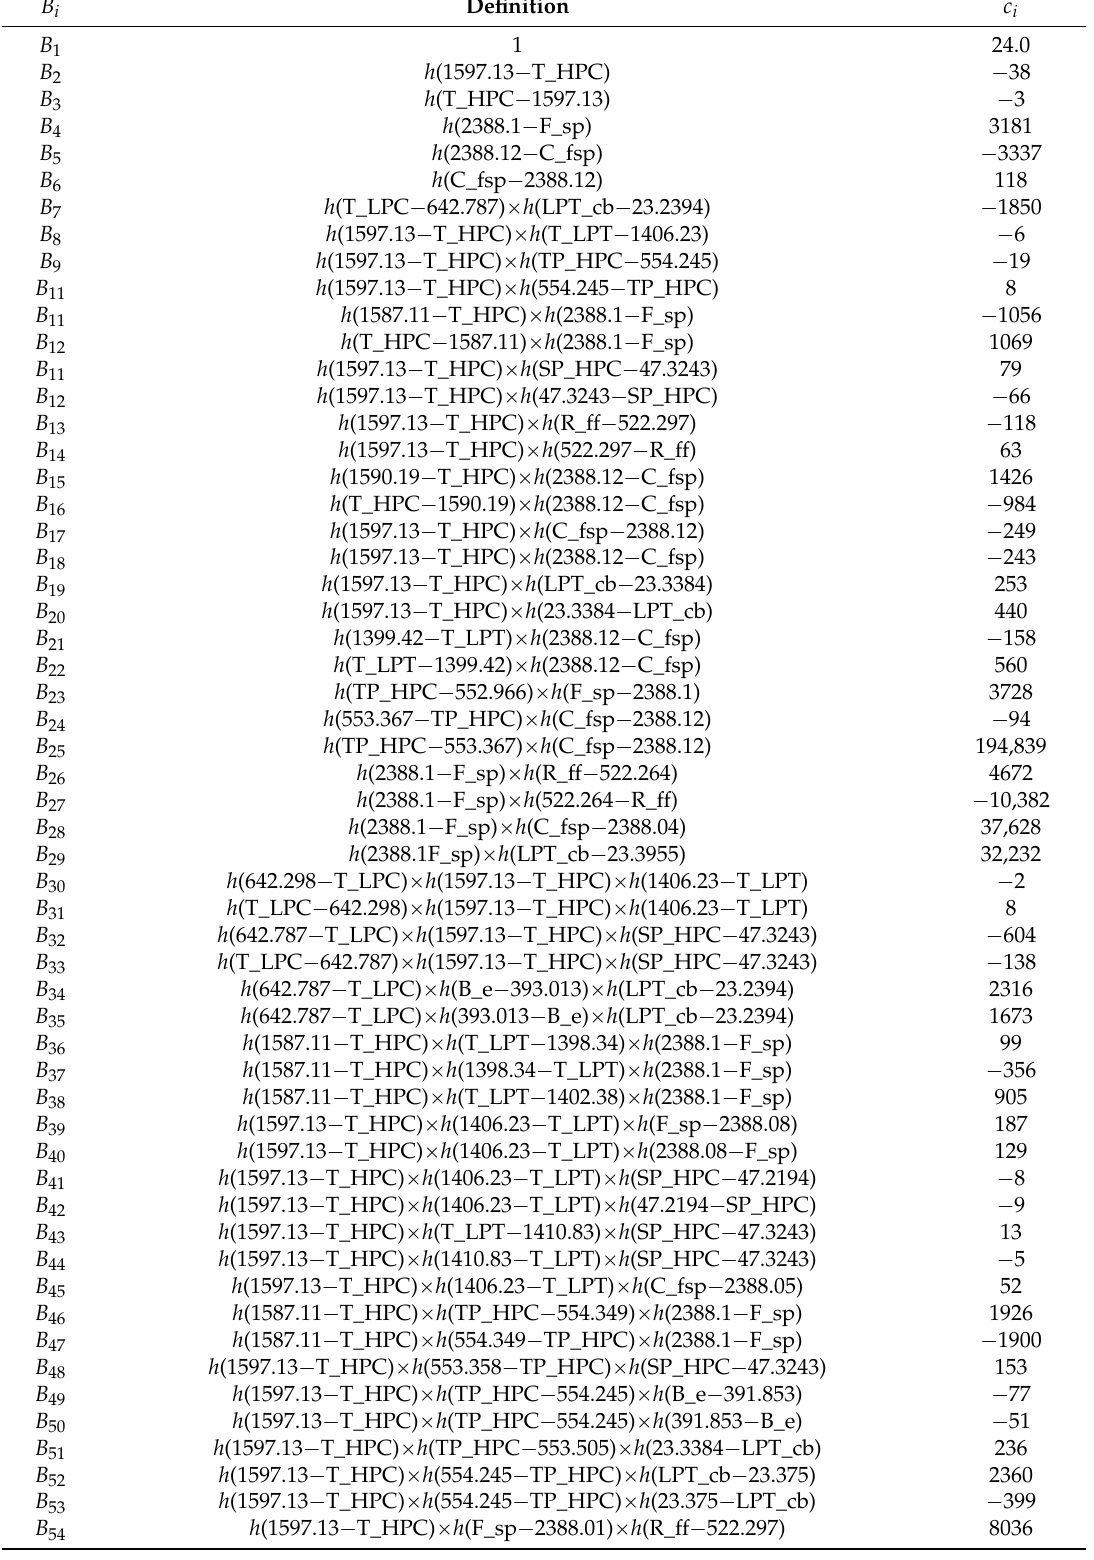
Table A1. List of basis functions of the best fitted ABC–MARS-based model for the RUL and their coefficients c i